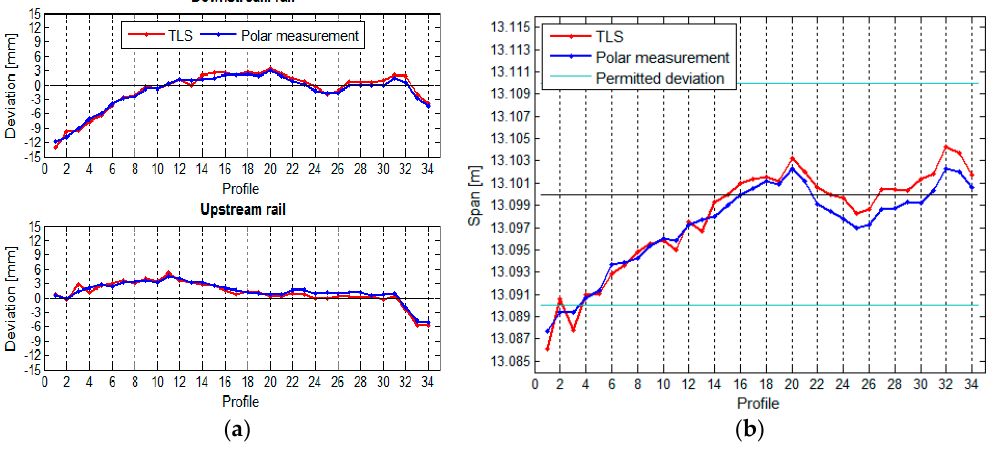
Figure 23. ( a ) Comparison of the horizontal deviations and ( b ) the spans between the rails.